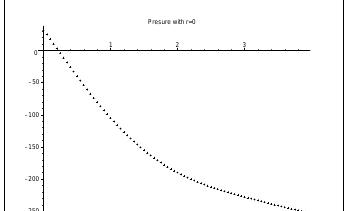
Figure 2. The distribution of pres- sure on an axis in smooth pipe A = − 2000 .